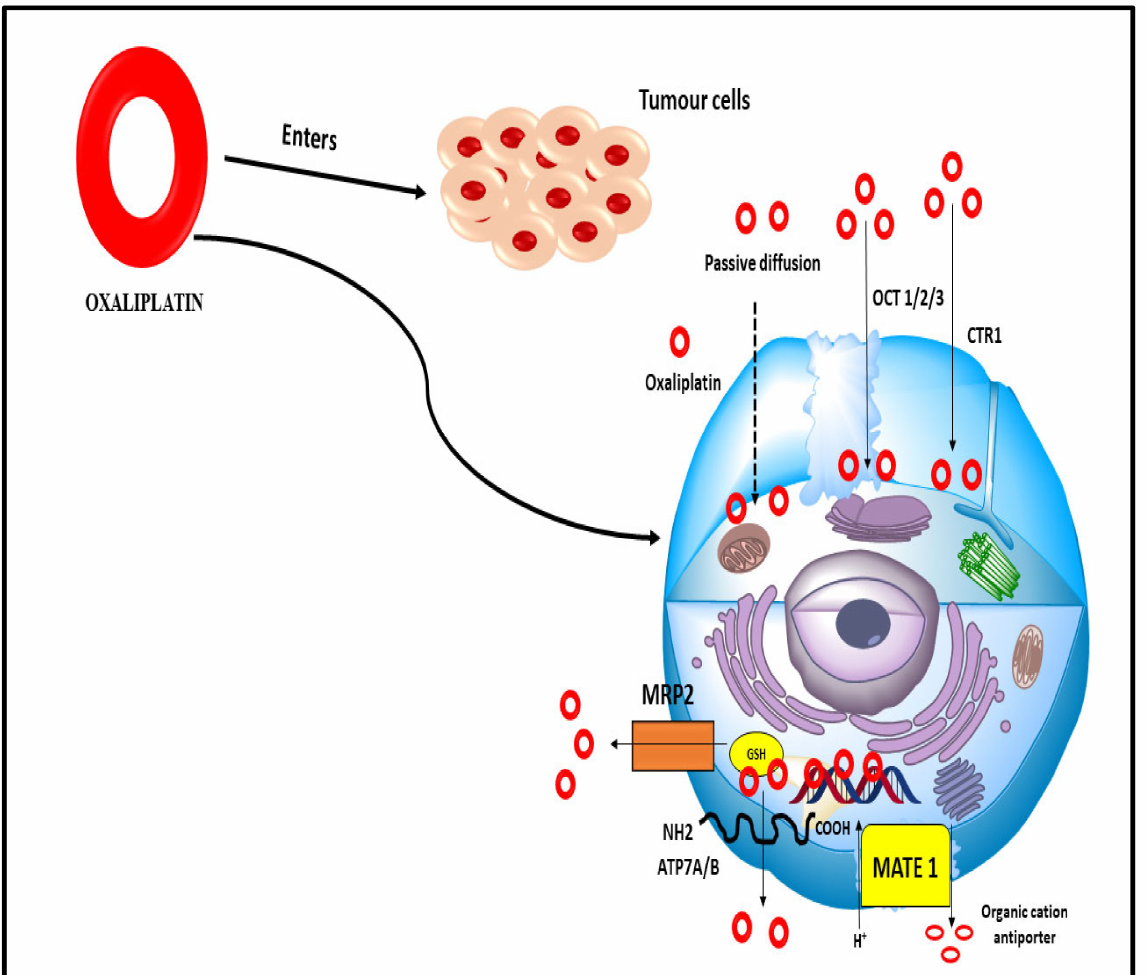
Figure 10. Numerous influx and efflux transporters that allow oxaliplatin to enter the cell passively (dashed arrow). There are several kinds of organic cation transporters, such as the OCT 1/2/3 trans- porters, copper transporters, MRP2 multidrug resistance-associated proteins, glutathione transporters, MATE 1 multidrug and toxin extrusion transporter, and ATP7A/B ATP-binding cassette